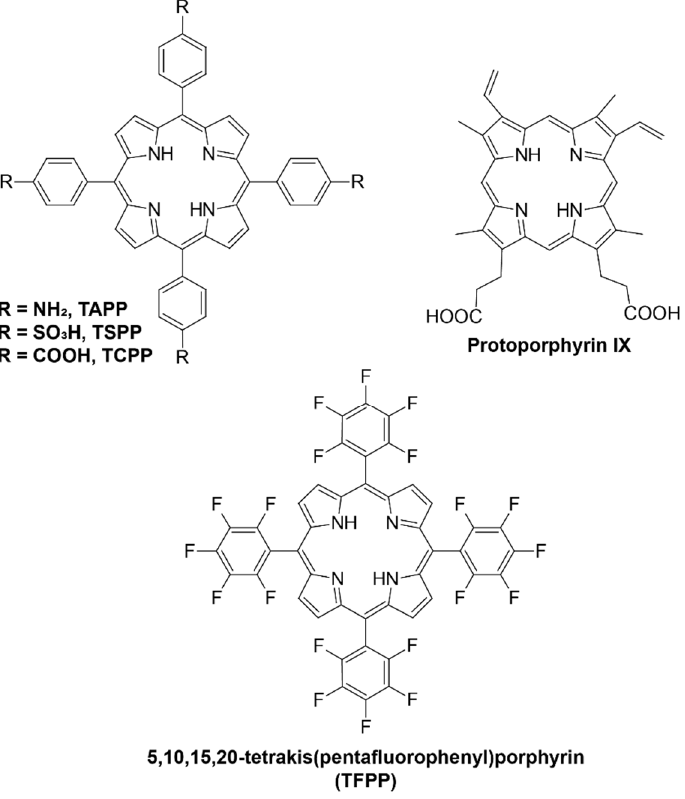
Figure 2. The structures of studied porphyrin ligands complexed with 64 Cu for use in PET.